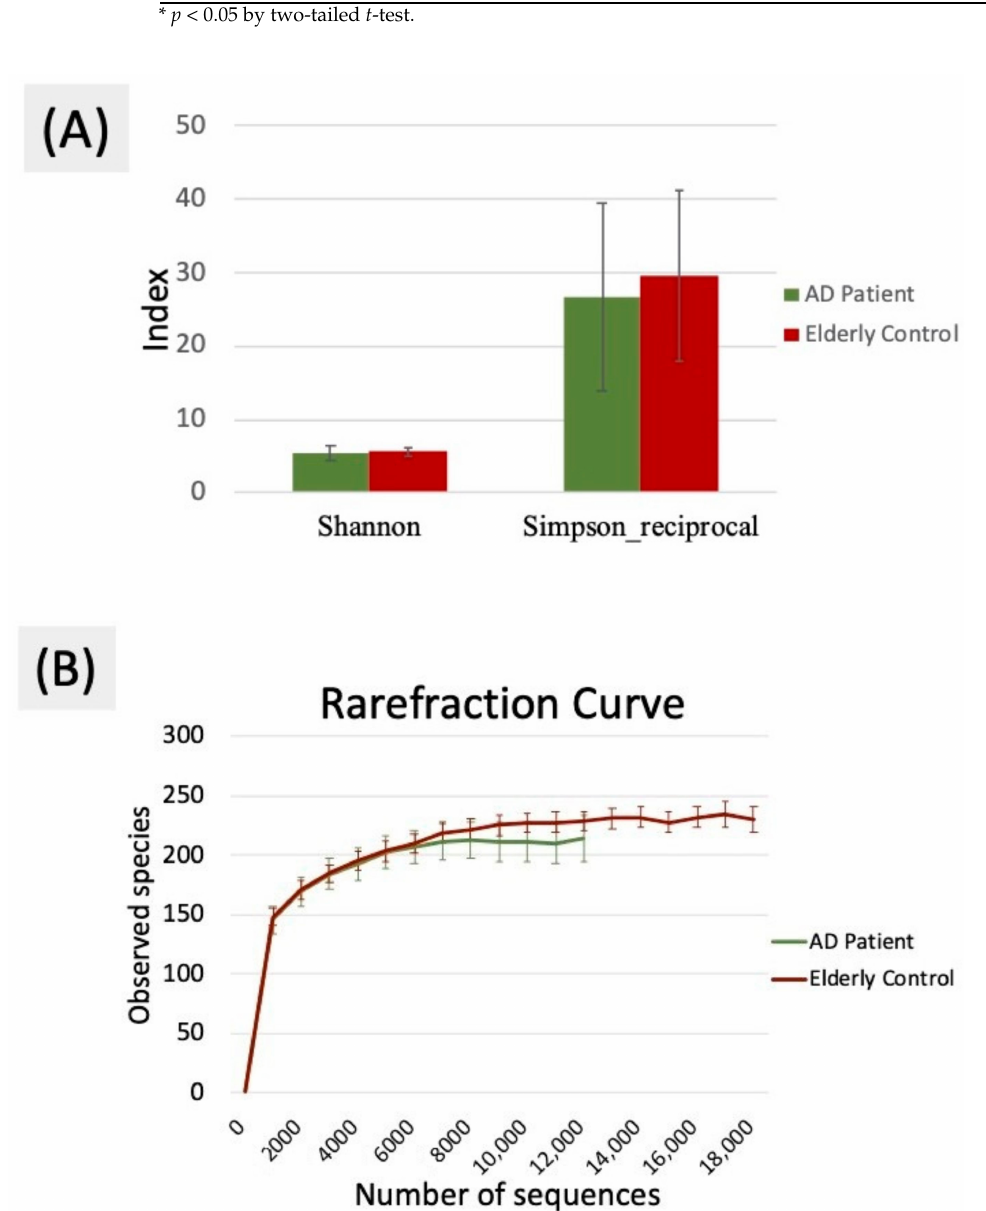
Figure 1. ( A ) Shannon and Simpson indices were used to estimate the level of diversity of the oral microbiota (data shown as the mean ± SD). ( B ) Alpha rarefaction curves were used to estimate the observed species of the oral microbiota of the AD and control